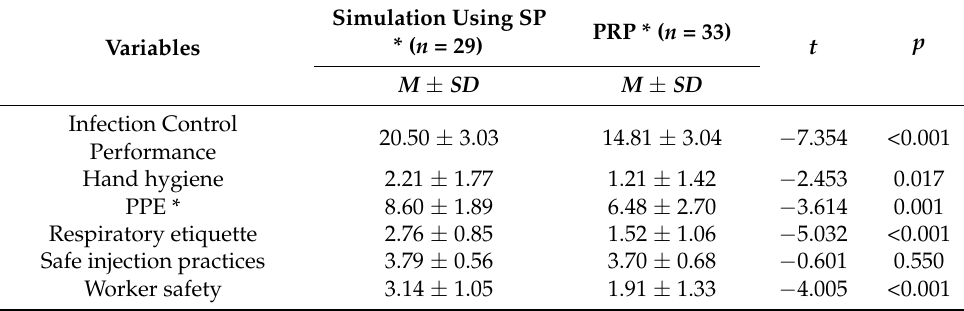
Table 5. Comparison of Infection Control Performance after Education ( N =